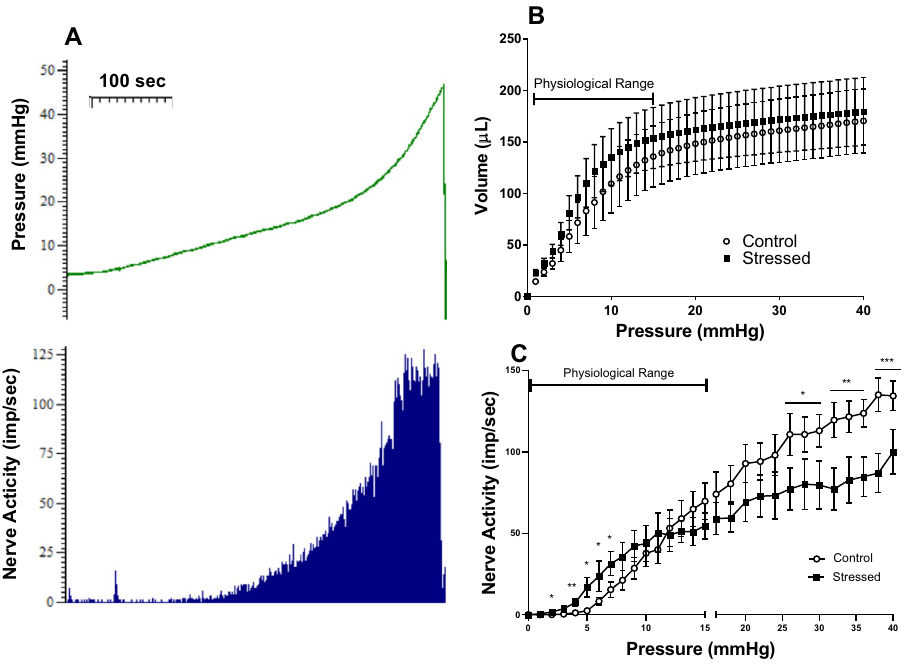
Figure 2. Example pressure and afferent nerve activity trace during bladder distension to 40 mmHg ( A ) in a control bladder. Bladder compliance during filling to 40 mmHg intravesical pressure ( B ) and total afferent nerve activity ( C ) during filling to 40 mmHg, data represented as mean ± SEM (n ≥ 5) and analysed by un-paired Students t test (*p < 0.05, **p < 0.01 and ***p < 0.01 control vs stressed bladders).